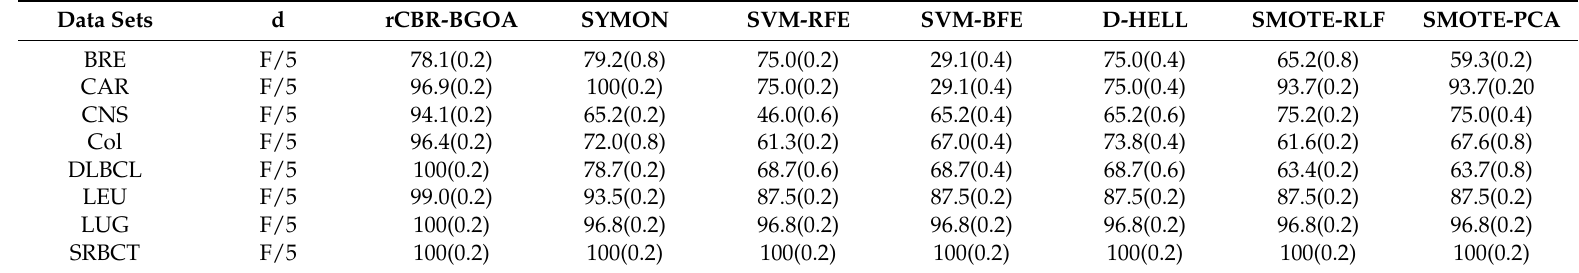
Table 5. AUC performance metric on microarray datasets and variant data sizes for the different methods F/5 means 20% of the total features in